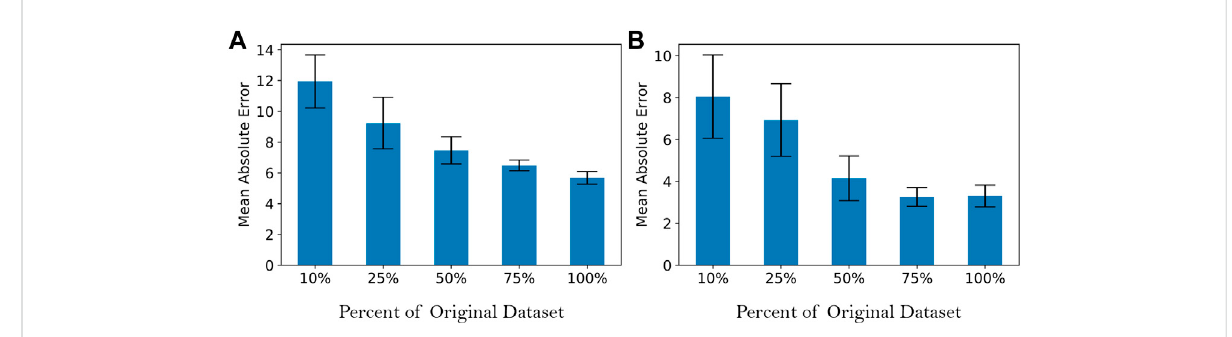
FIGURE 5 Effectofdatasizeonmeanabsoluteerroroftestdataforthearti fi cialneuralnetworkmodelfor: (A) totalsolublexyloseyieldand (B) monomeric xylose yield. Mean absolute error was determined from fi ve replicates of the computational experiment. Its units are percentage points of